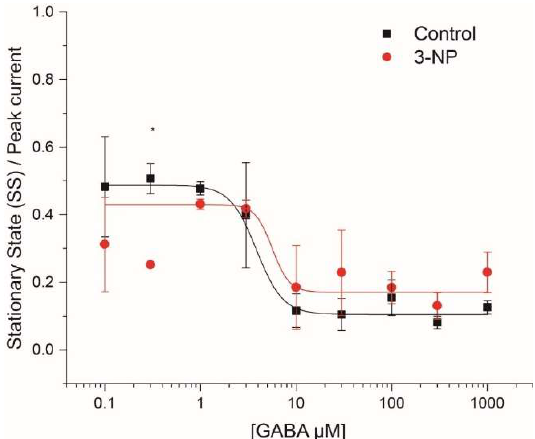
Figure 4. Steady-state versus peak GABA-activated current. The SS/peak parameter was used as a measure of GABA receptor desensitization for concentrations of 0.1 µM, 0.3 µM, 1 µM, 3 µM, 10 µM, 30 µM, 100 µM, 300 µM and 1000 µM in MSNs of both evaluated groups. Data Analysis showed differences in 0.3 µM GABA concentration but no between groups or in the interaction (F 8, 17 = 5.53, p < 0.001, Two way ANOVA).